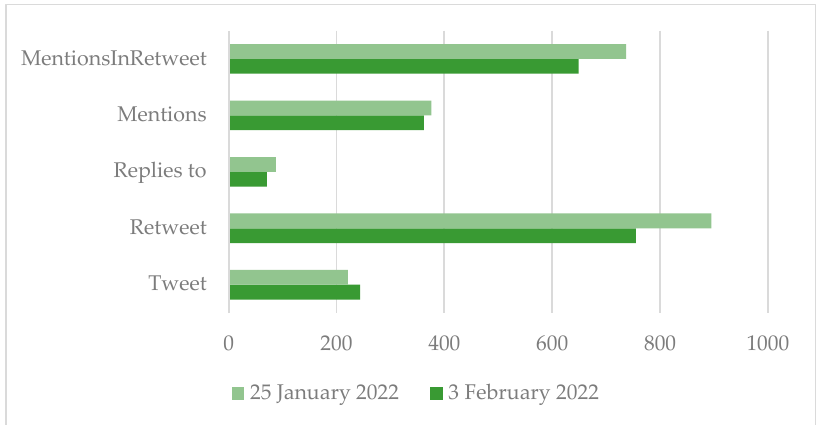
Figure 2. Number of tweets per category.